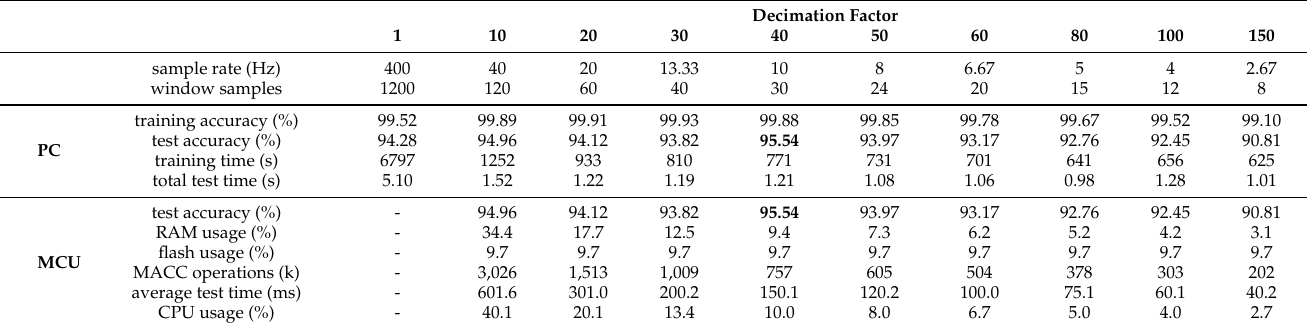
Table 5. Experimental results, best results displayed in